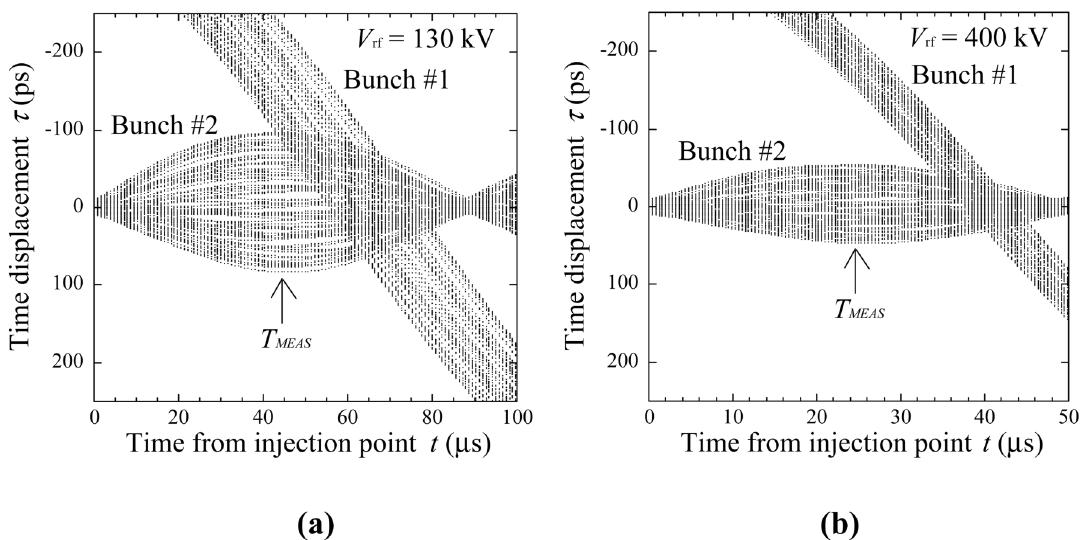
FIG. 7. Streak camera image of bunches #1 and #2, for simulation results with (a) a normal operation voltage and (b) a high rf voltage. The specified beam parameters are 0.5% for the full energy spread and 20 ps for the bunch length. The image is a trace of 200 particles per